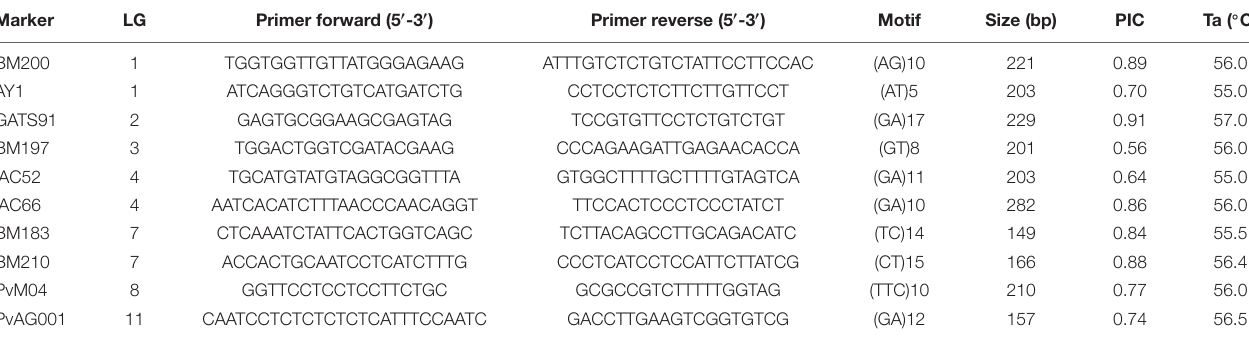
TABLE 2 | List and basic information of the primer pairs for the Microsatellite (neutral) marker loci selected for DNA genotyping. Marker LG Primer forward (5 (cid:48) -3 (cid:48) ) Primer reverse (5 (cid:48) -3 (cid:48) )